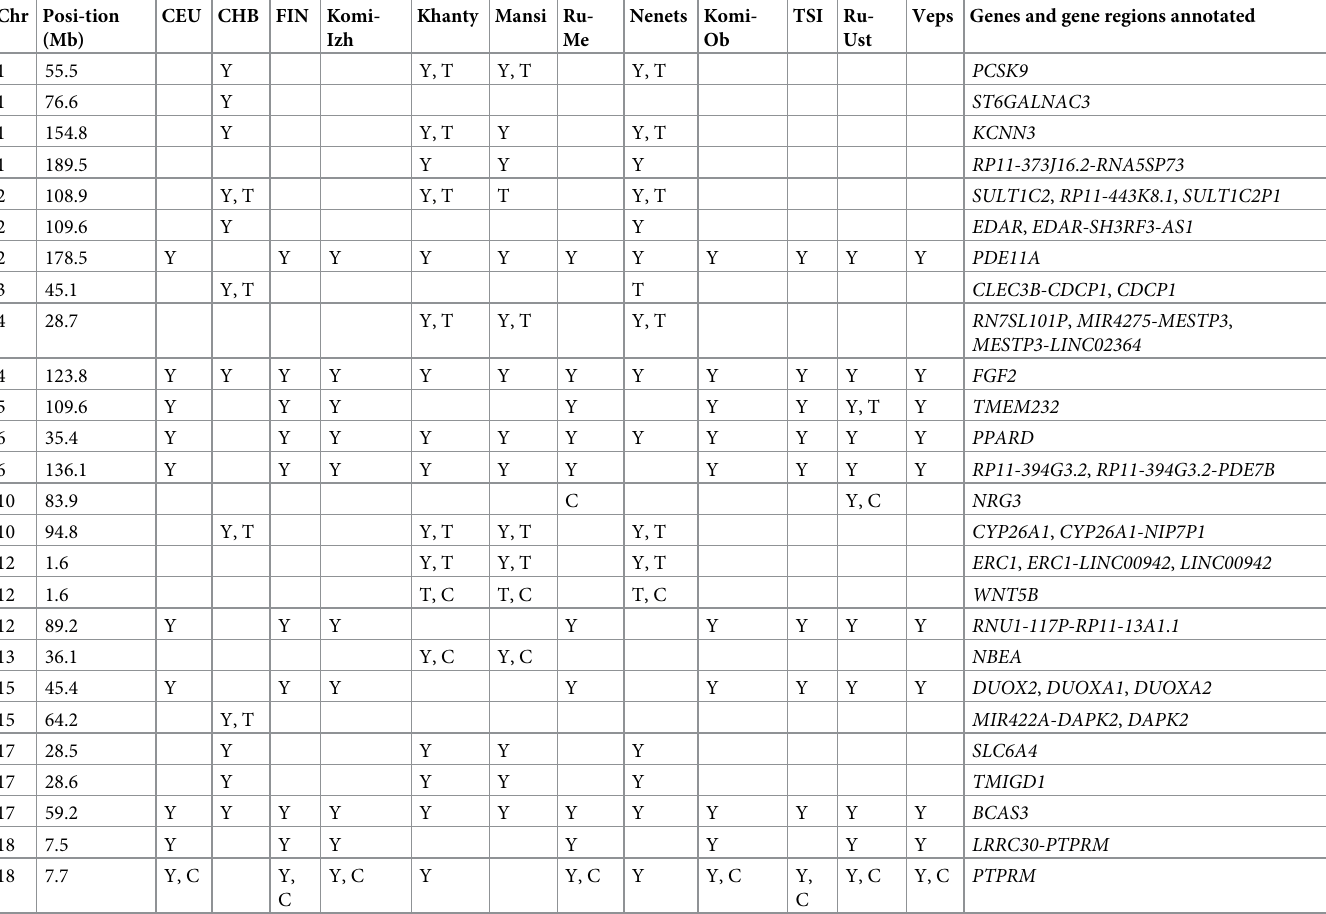
Table 2. Candidate loci for positive selection identified using XP-EHH tests (p � 1 x 10 − 5 ) � . Chr Posi-tion CEU CHB FIN Komi- (Mb)